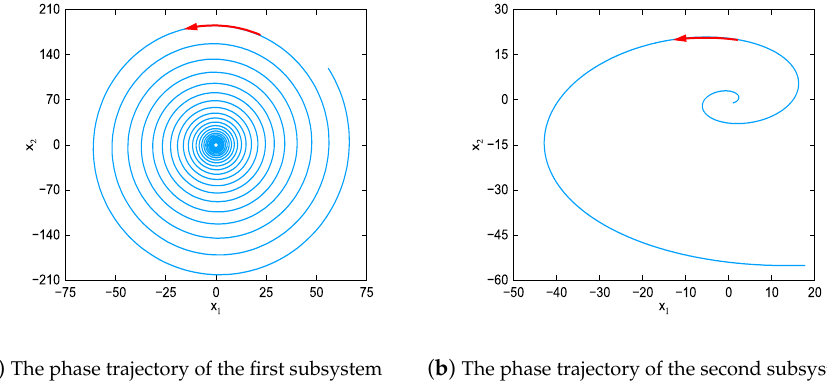
Figure 5. The phase trajectories of the two